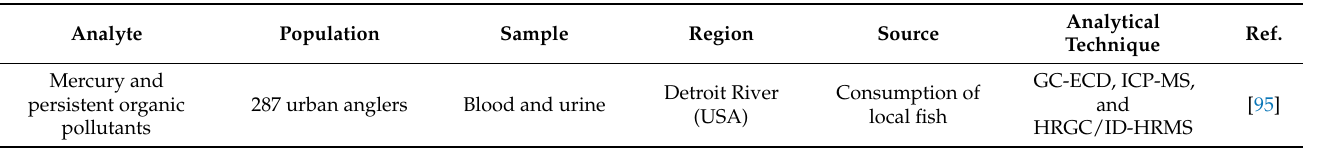
Table 3. Scientific studies on the correlation between a water source and the presence of certain pollutants in a human